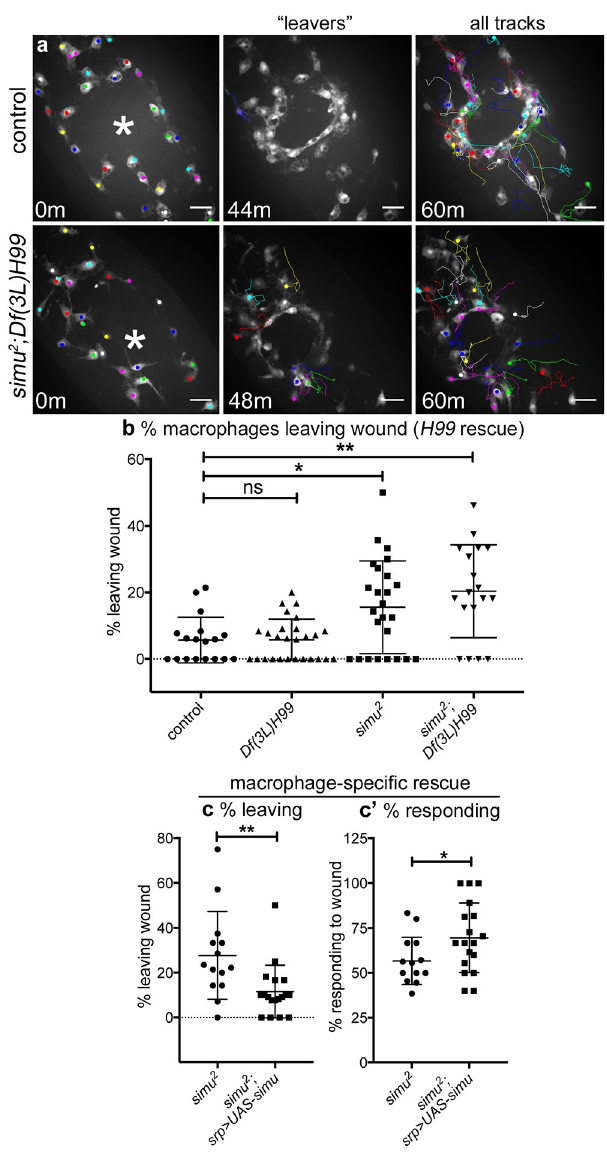
Fig 8. Simu is required to prevent precocious exit of macrophages from sites of inflammation. (a) GFP-labelled macrophages and their associated tracks at 0, 44, or 48 and 60 minutes post wounding in controls and simu mutants lacking apoptosis ( simu 2 ; Df(3L)H99 ). Left panels show macrophages present in field of view at 0 minutes; asterisk marks centre of wound. Central panels show tracks of macrophages that migrate to and then leave the wound (‘leavers’). Right panels show tracks of cells present at 0 minutes that remain in the field of view until 60-minutes post wounding. (b–c) Scatterplots showing percentage of macrophages that migrate away from wounds over the course of 60-minute movies of inflammatory responses in controls, apoptosis-null embryos ( Df(3L)H99 ), simu mutants ( simu 2 ), and simu mutants lacking apoptosis ( simu 2 ; Df(3L)H99 ) (b) and upon macrophage-specific re-expression of wild-type simu in a simu mutant background (c); P values compared to control in (b) are P = 0.999, 0.047, and 0.031, respectively from left to right (Kruskal–Wallis test with Dunn’s multiple comparisons post-test; n = 18, 27, 25, 18); for (c) P = 0.004 (Mann–Whitney test, n = 14 and 18). (c’) Scatterplot of percentages of cells responding to wounds in simu mutants and simu mutants with re-expression of wild-type simu in macrophages ( n = 14 and 18, P = 0.045, Mann–Whitney test). Genotypes are as follows: (a–b) control ( w;;crq-GAL4 , UAS-GFP ), Df(3L)H99 ( w;;Df(3L)H99 , crq-GAL4 , UAS-GFP ), simu 2 ( w;simu 2 ; crq-GAL4 , UAS-GFP ), and simu 2 ; Df(3L)H99 ( w;simu 2 ; Df(3L)H99 , crq-GAL4 , UAS-GFP );(c) simu 2 ( w; simu 2 , srp-GAL4 , UAS-red stinger/simu 2 ; crq-GAL4 , UAS-GFP/+ ) and simu 2 ; UAS-simu ( w;simu 2 , srp-GAL4 , UAS-red stinger/simu 2 ; crq-GAL4 , UAS-GFP/UAS-simu ). Lines and error bars show mean and standard deviation in scatterplots; scale bars represent 20 μ m (a). All data used to plot graphs may be found in Supporting information file S1 Data. GFP, green fluorescent protein; UAS, upstream activating sequence.